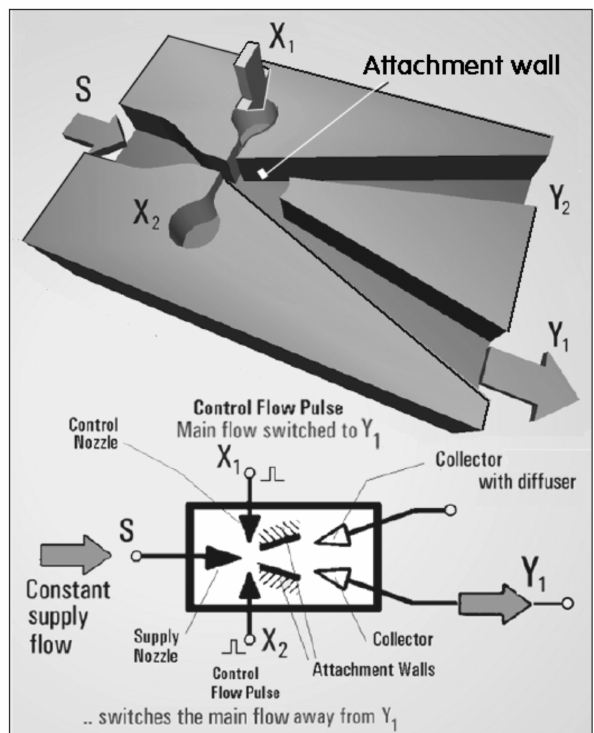
Figure 6. Typical present-day series—produced amplifier of the jet-deflection type. It is actually an integrated version of two amplifiers, like those shown in Figure 5—in addition to which, making it particularly suitable for the generation and amplification of flow pulses, are the Coanda-e ff ect attachment walls. From [13].